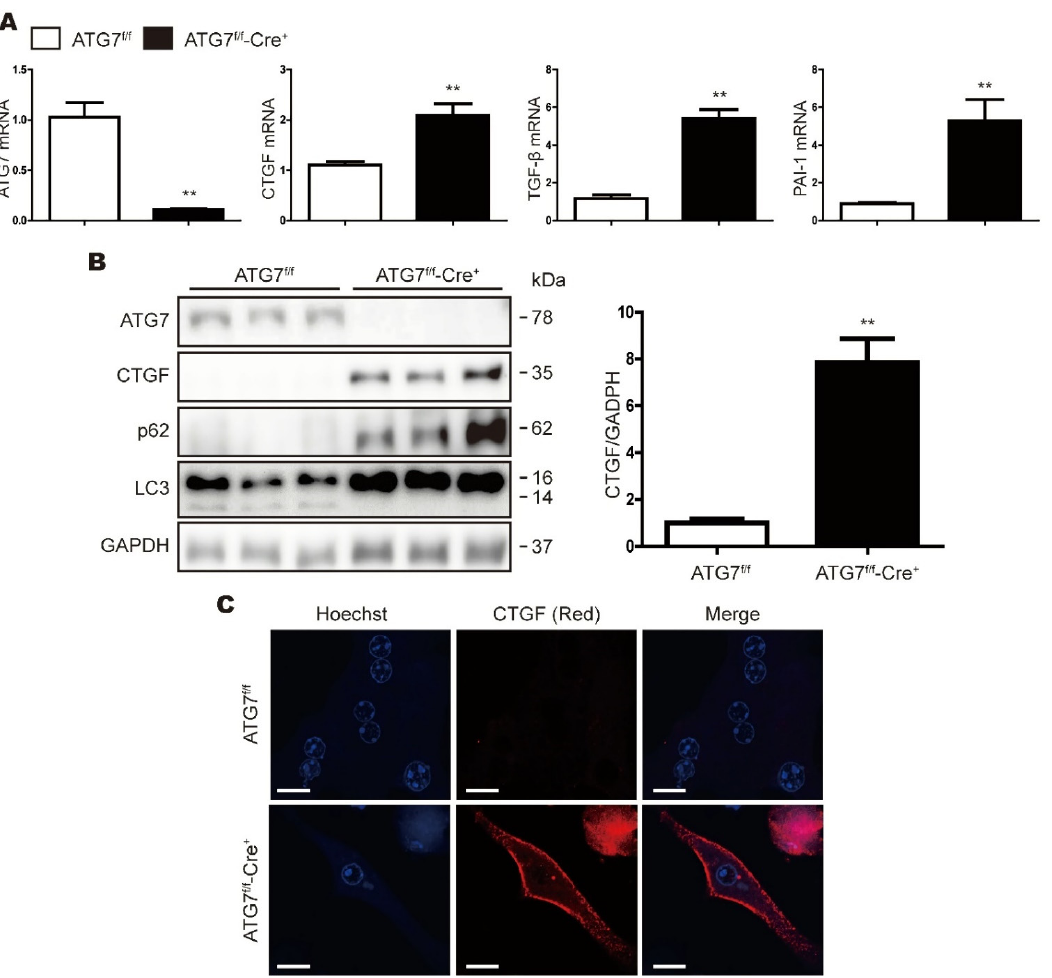
Figure 2. CTGF expression is increased in primary hepatocytes from Cre-positive ATG7 Flox/Flox mice. ( A ) Real-time RT PCR analysis of ATG7, CTGF, TGF- β and PAI-1 mRNA expression in primary hepatocytes from Cre-negative and Cre-positive ATG7 flox/flox (ATG7 f/f and ATG7 f/f -Cre + ) mice (n = at least 10 per group). The data represent the mean ± SEM, and are normalized to the levels in ATG7 f/f mice; ** p < 0.01. ( B ) Representative Western blot analysis of CTGF, SQSTM1/p62 and LC3 in ATG7 f/f and ATG7 f/f -Cre + mice. GAPDH expression was measured as a loading control. The data in the graph represent the mean ± SEM (n = at least 10 per group), and are normalized to the levels in ATF7 f/f mice; ** p < 0.01. ( C ) Representative IF microscopy analyses of CTGF in ATG7 f/f and ATG7 f/f -Cre + mice. The cell nuclei are shown in blue.